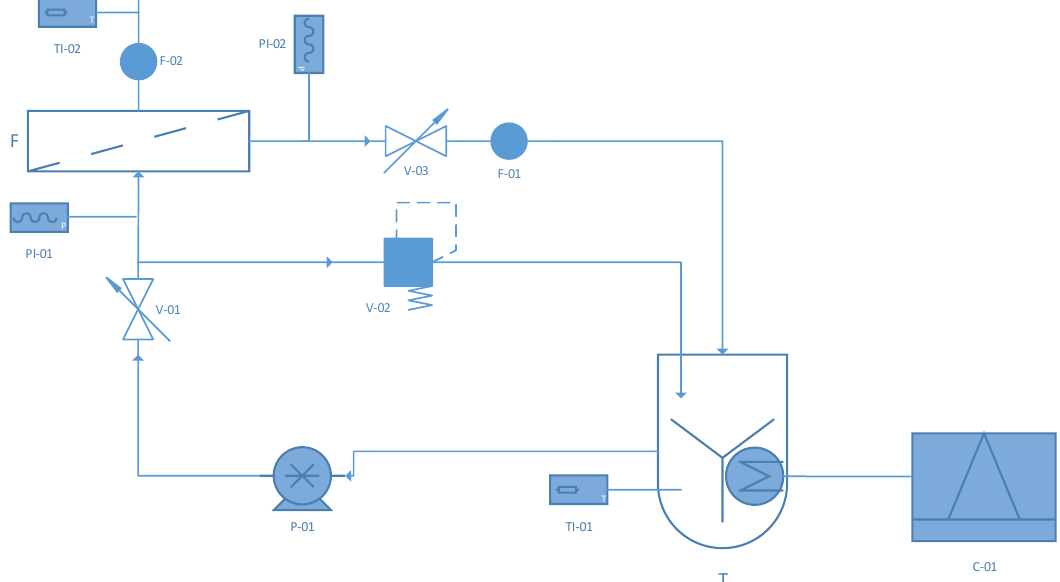
Fig 3. Schematic of permeation system used (F: permeation cell; T: feed tank; C-01: chiller; V-01/03: needle valves; V-02: pressure-release valve; P-01: pump; F-01/02: flowmeters; PI-01/02: pressure gauges; F-01/02: flowmeters; TI-01/02: thermometers) These tests were performed for 5 hours, and the membrane parameters were measured every hour. Prior to the permeation tests, the membranes were immersed in water overnight for equilibration under wet conditions and to minimize any defects in the membranes resulted from dry